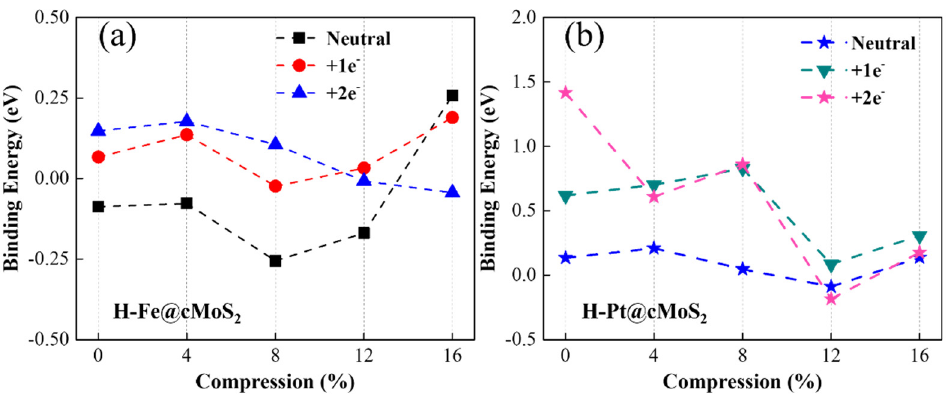
Figure 5. Binding energy of Fe@cMoS 2 ( a ) and Pt@cMoS 2 ( b ) as a function of compressions at neutral, +1e − and 2e − situations.